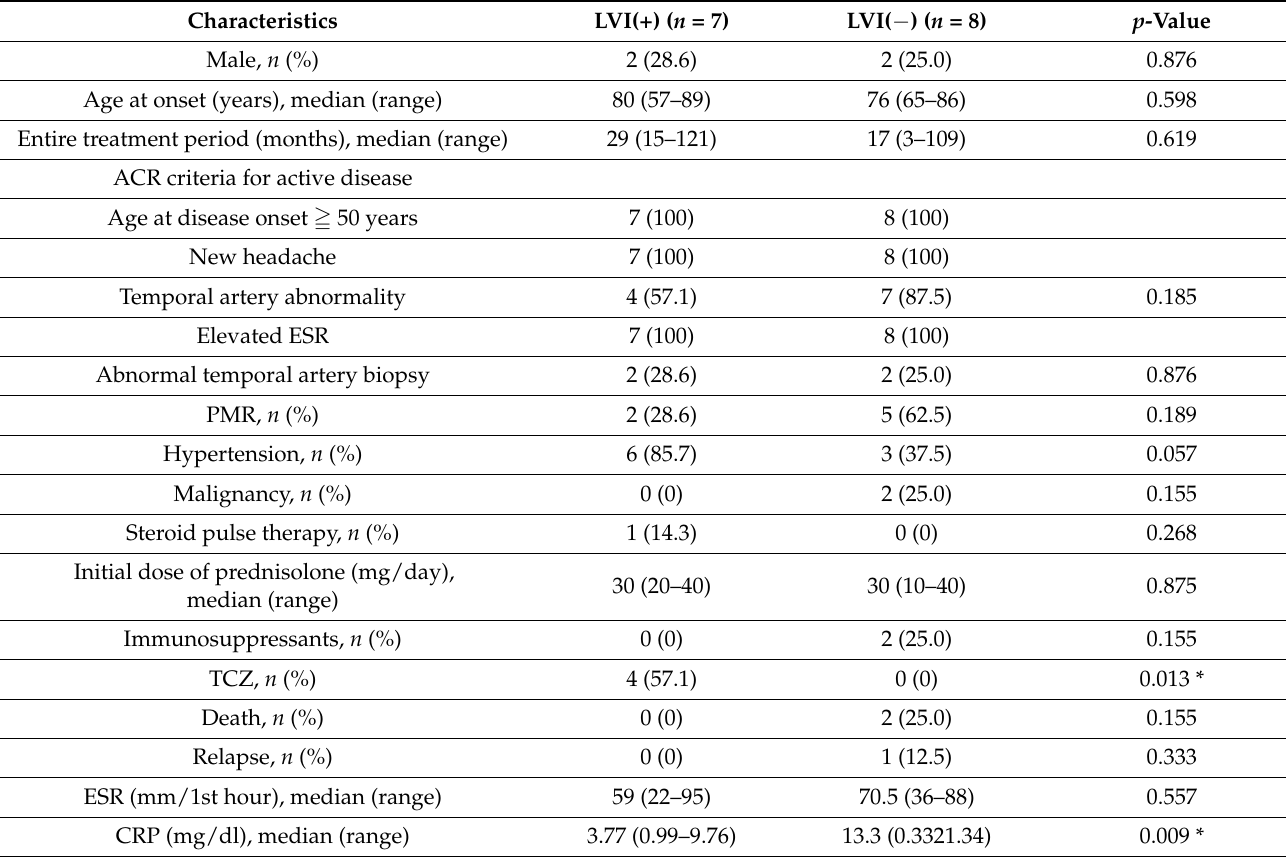
Table 4. Comparisons of clinical features between LVI(+) and LVI( − )